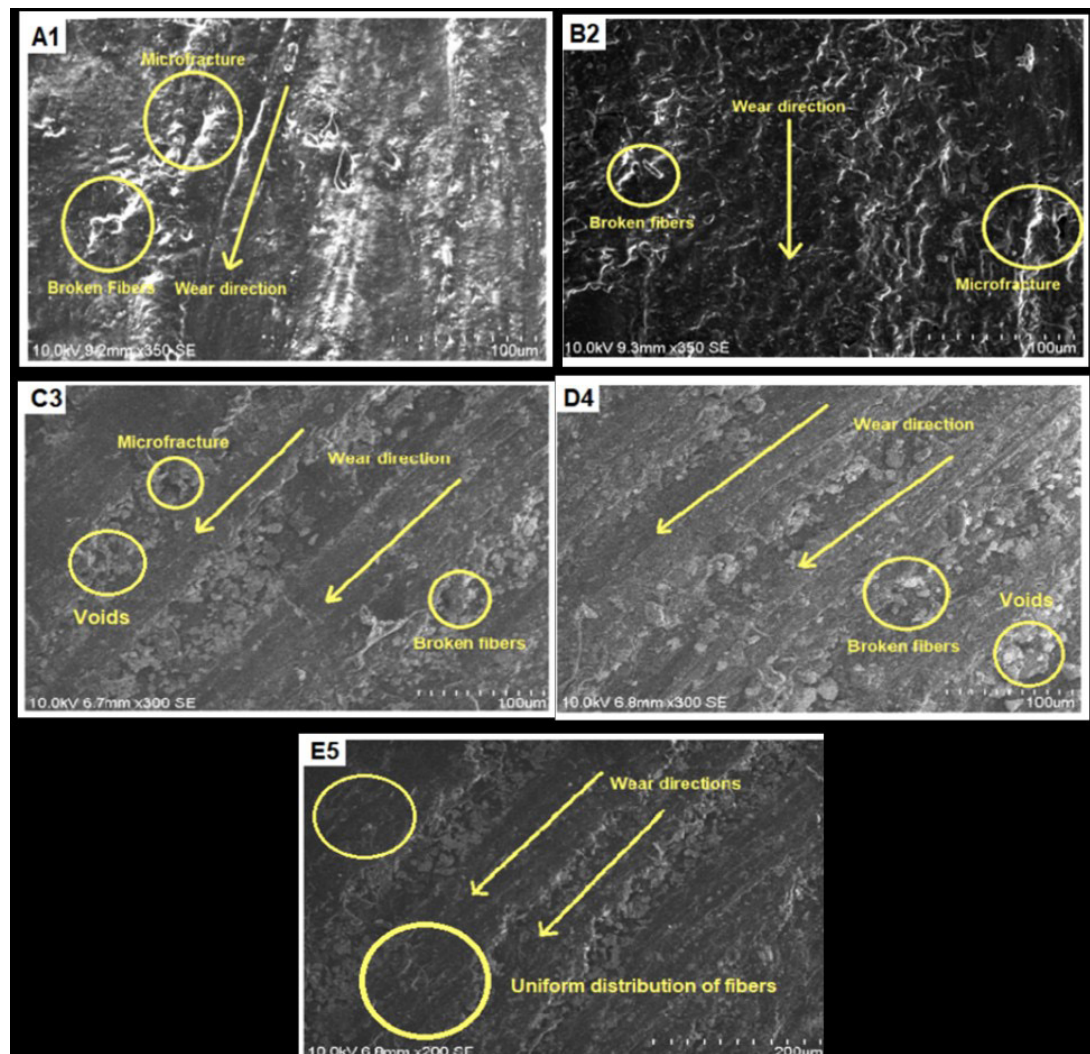
Figure 13. SEM morphologies for worn-out surfaces of hybrid samples.